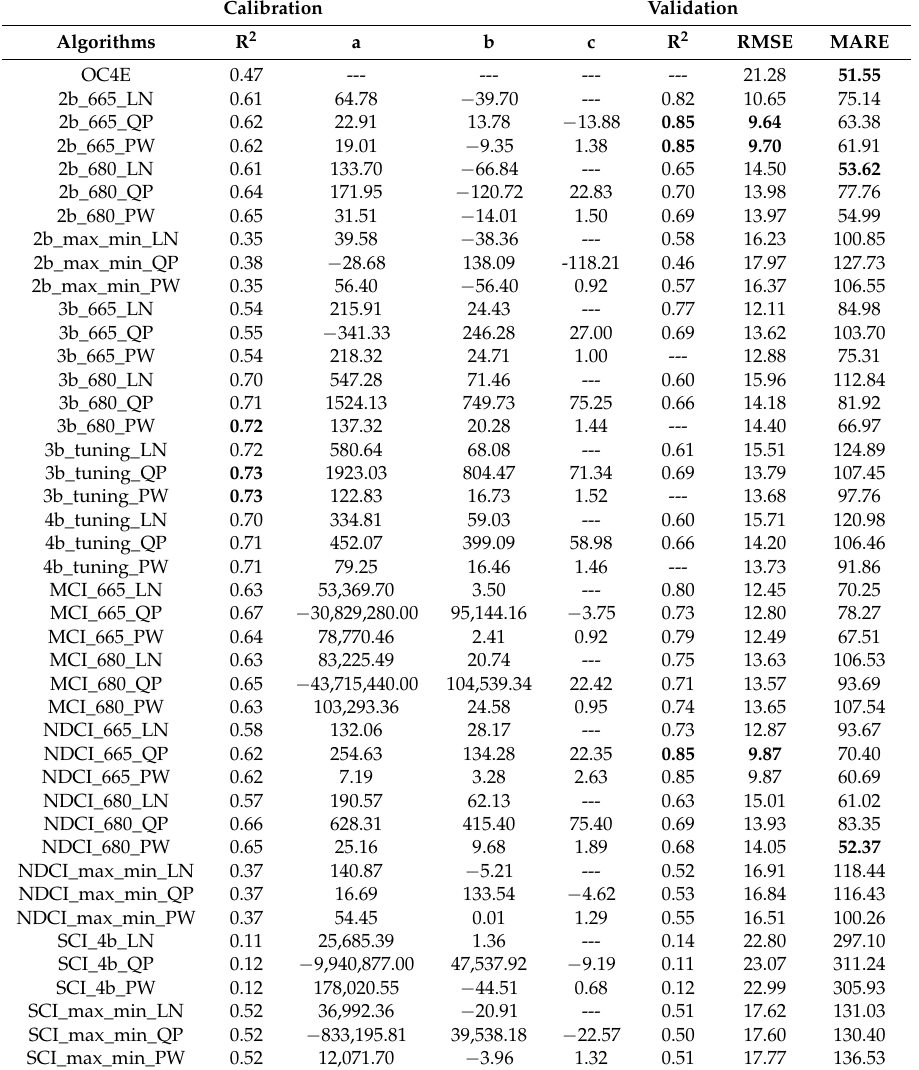
Table 6. Algorithms’ evaluation during the calibrations and validation stages of in-situ dataset. Calibration Validation